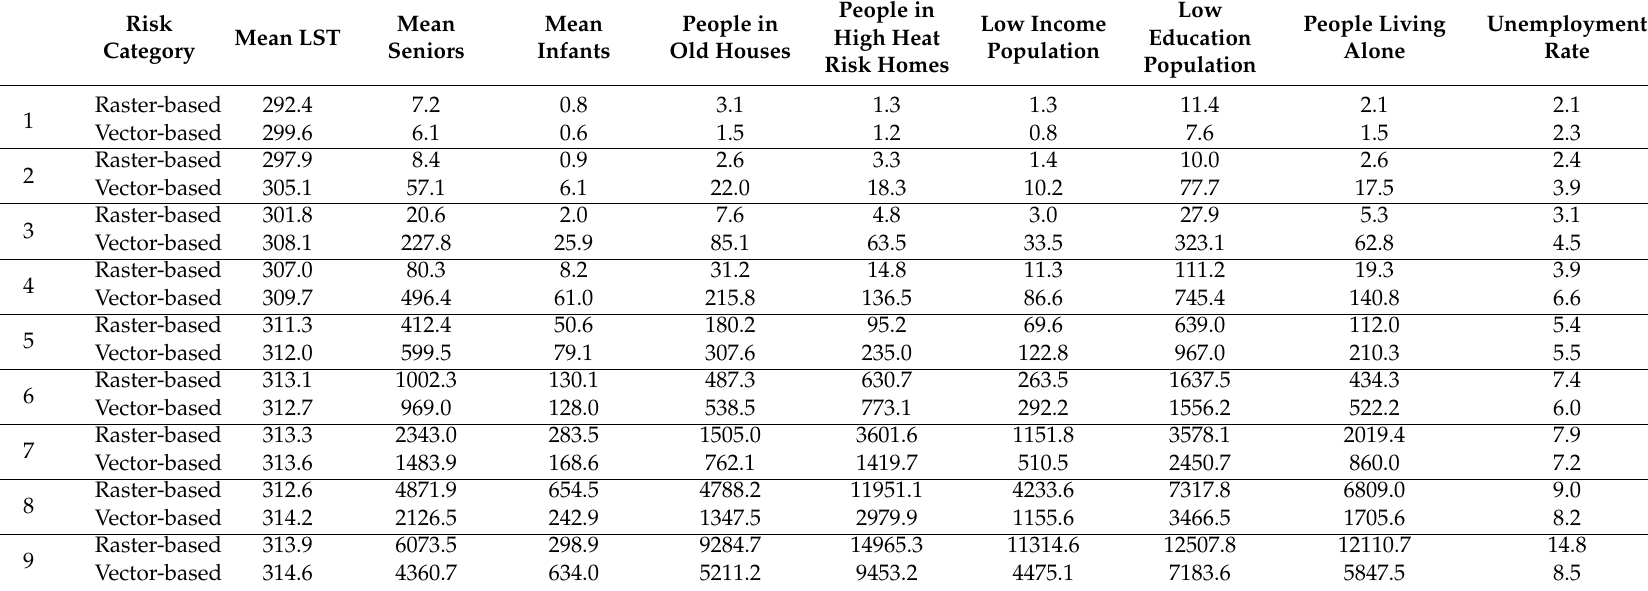
Table 2. Comparison of heat risks from raster-based and vector-based model. Each type of heat risk was evaluated with the mean value of exposure and vulnerability